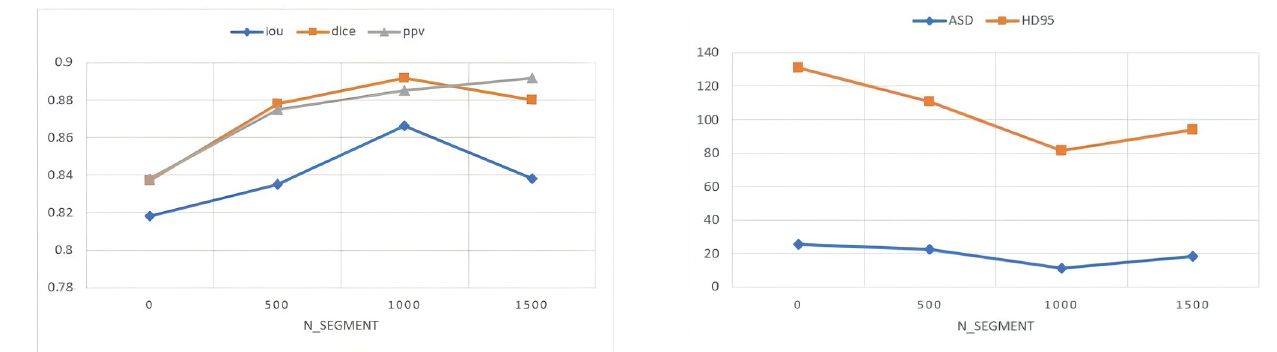
Figure 5. Performances of our method with different values of N_Segment on PH2 dataset. The HD95 and ASD are in mm.